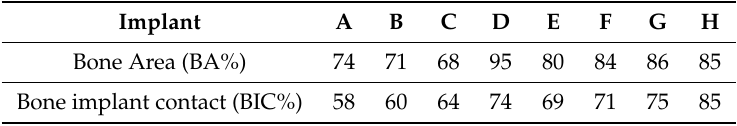
Table 1. The values of BA and BIC of implants A to